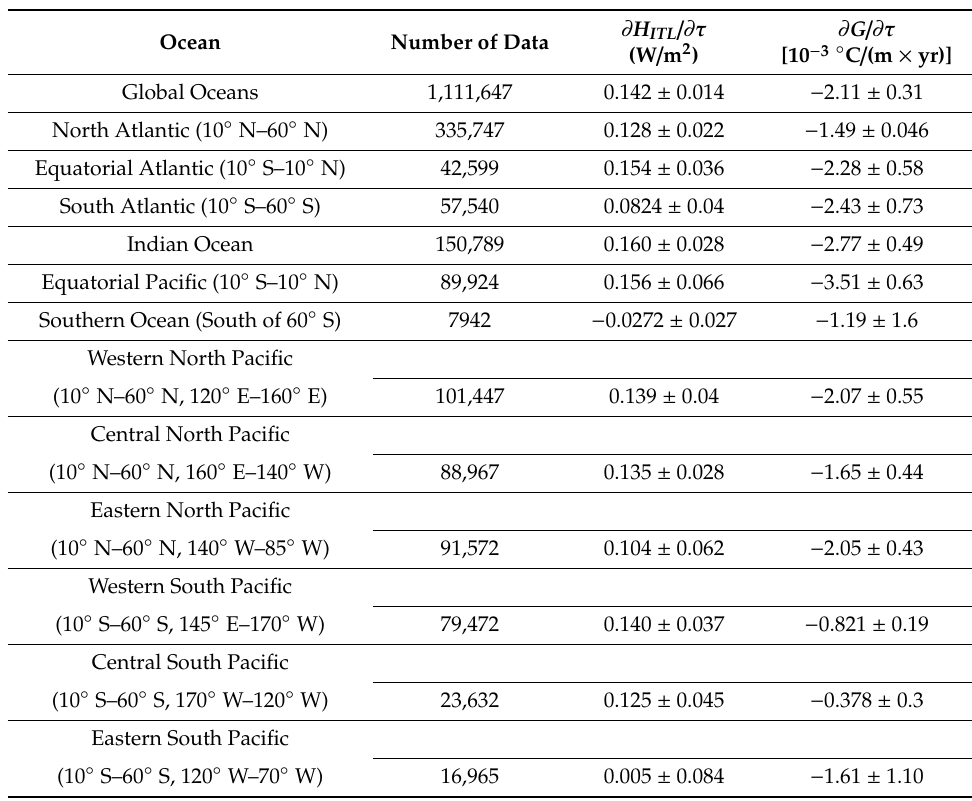
Table 4. Trends of H ITL and G for di ff erent parts of world